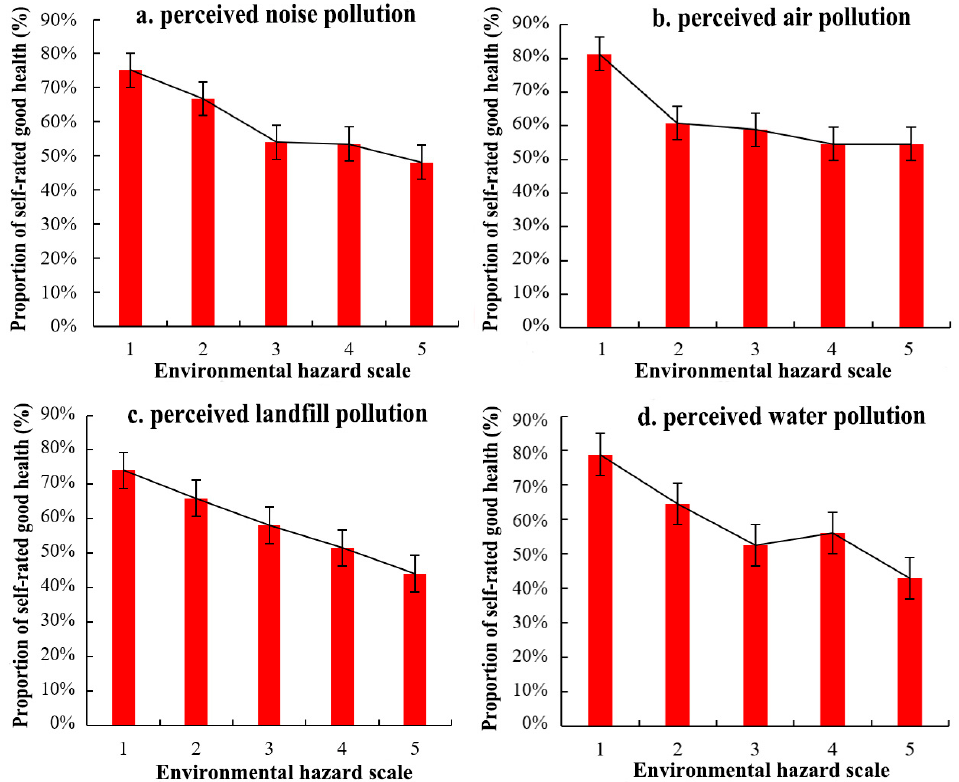
Figure 4. Proportion of residents reporting self-rated good health by four perceived environmental hazard types (( a ) noise pollution, ( b ) air pollution, ( c ) landfill pollution, ( d ) water